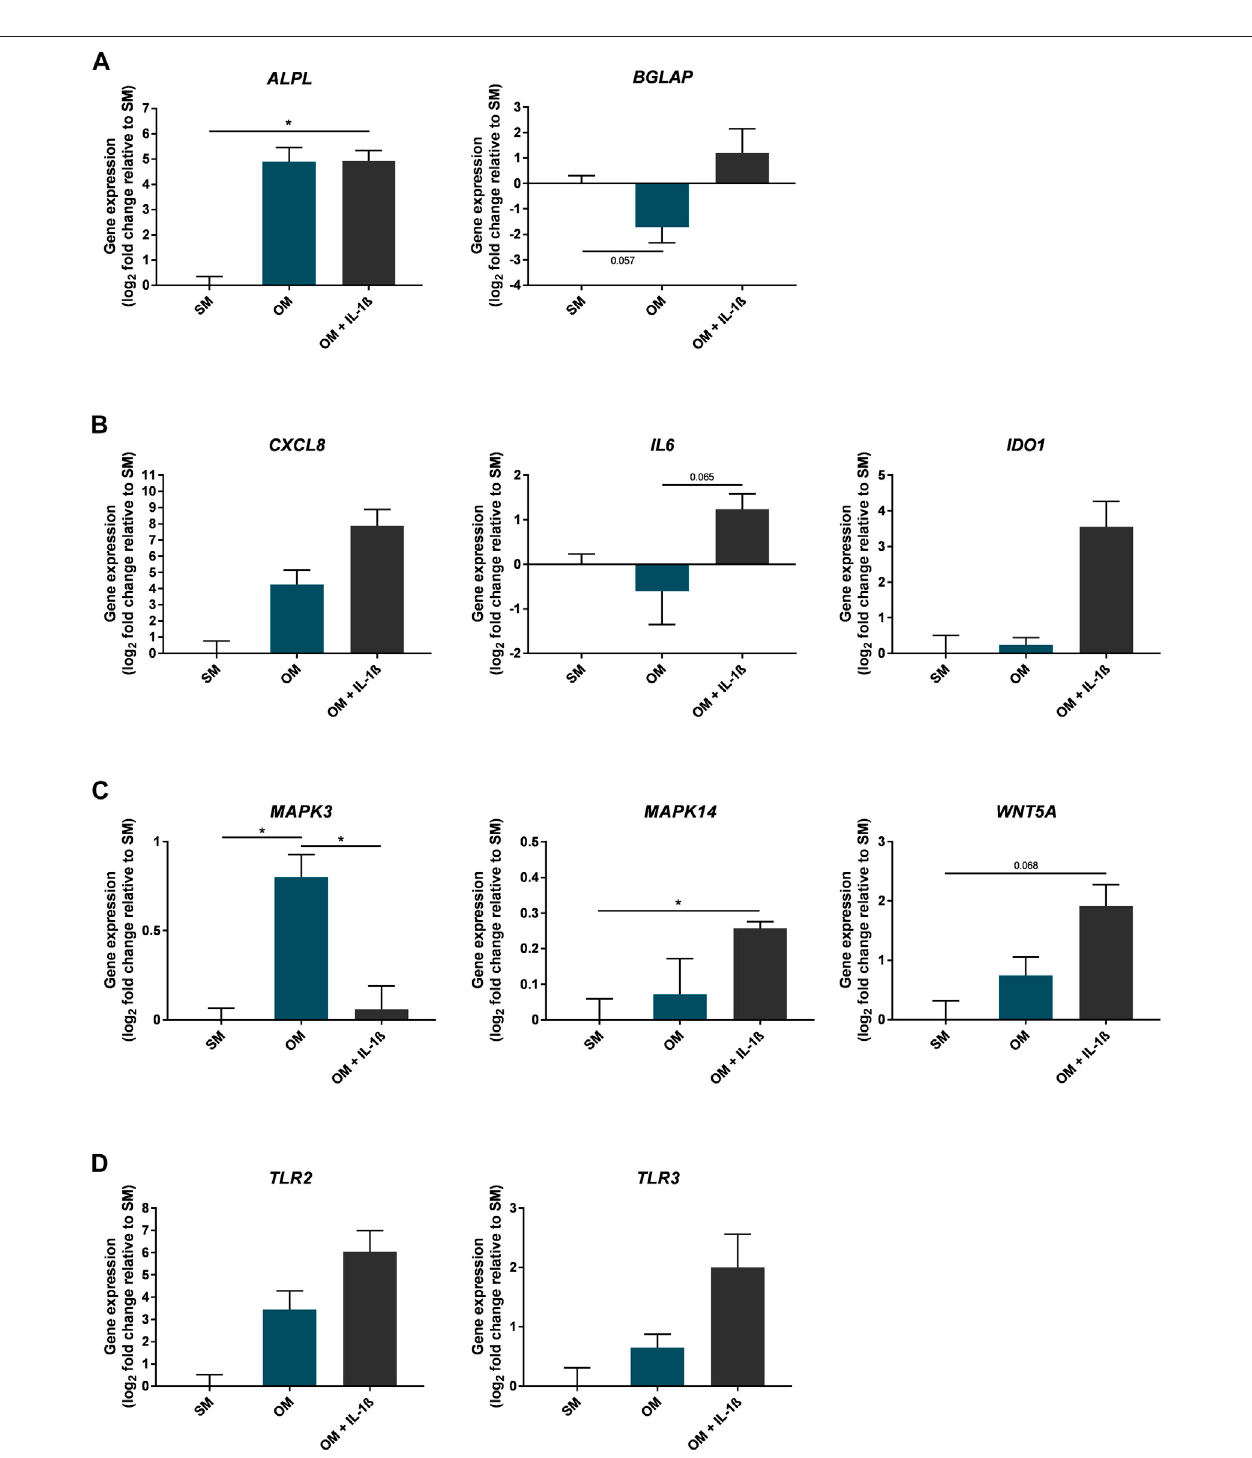
FIGURE 8 | Gene expression changes in response to IL-1 β (100 pg/ml) added to MSC cultures in osteogenic medium over 10 days. Gene expression of osteogenic (A) , in fl ammatory mediators (B) ,MAPKenzymesand Wntsignallingfactors (C) ,and toll-likereceptors (D) .Datashown aslog 2 foldchange compared toSM control condition. Error bars represent SEM. n = 3, * p < 0.05.